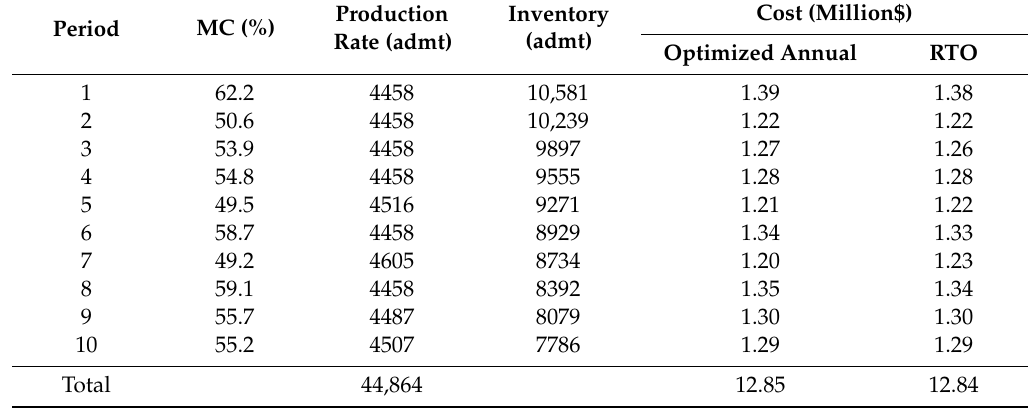
Table 3. Real-time optimization (RTO) results in the month of June.